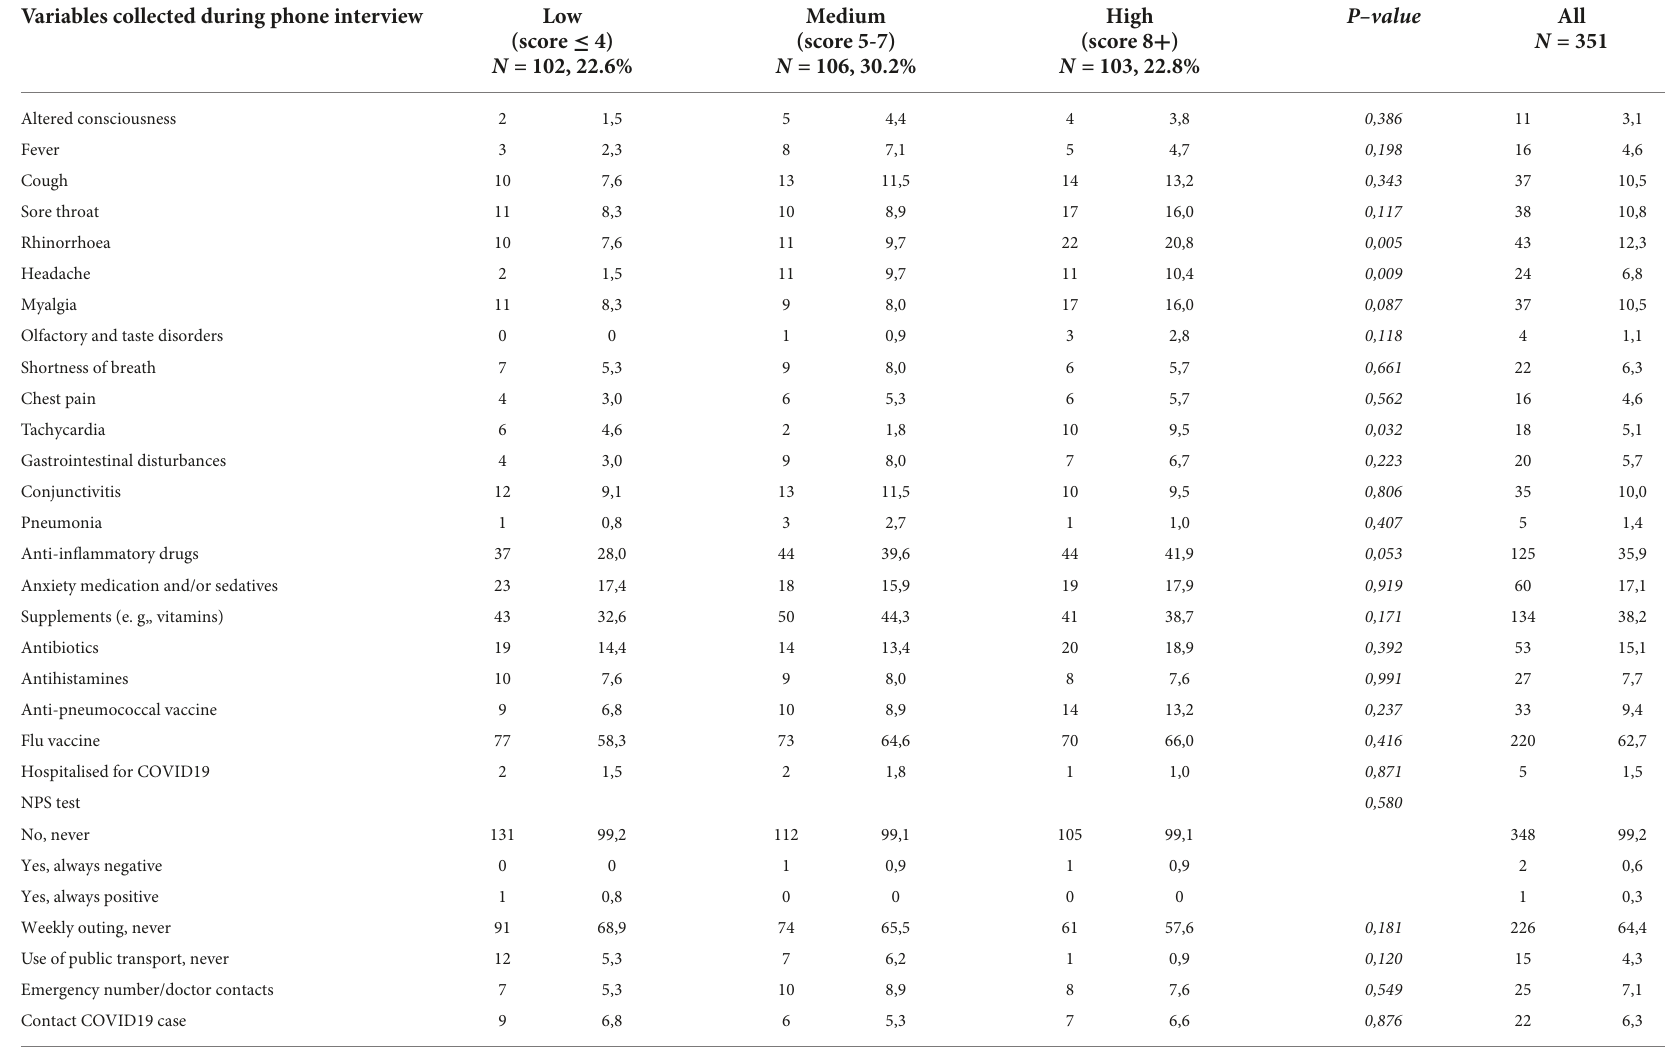
TABLE 2 Follow-up characteristics of participants by tertiles of fear score ( N =